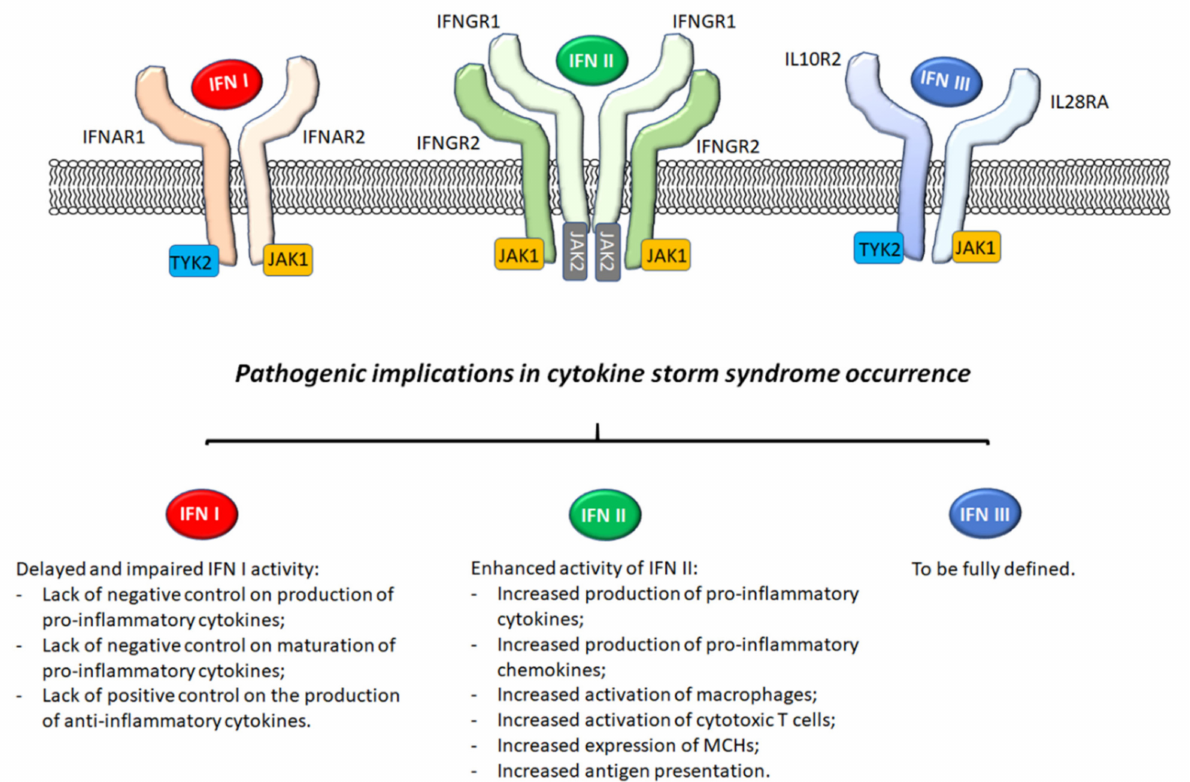
Figure 1. Pathogenic implications of IFNs in a cytokine storm syndrome occurrence. Type I IFNs bind to the IFNAR complex, consisting of two different chains, IFNAR1 and IFNAR2. Type II IFN activates the IFNGR, which is composed of two different chains, IFNGR1 and IFNGR2, and type III IFNs signal through a receptor complex made up of IL28RA and IL10R2. The impairment of the functions of type I IFNs or its delayed response may be implicated in the development of a cytokine storm syndrome lacking the negative control of production and maturation of pro-inflammatory cytokines as well as lacking the positive control on the production of anti-inflammatory cytokines. The enhanced activity of IFN II results in occurrences of cytokine storm syndrome via increased production of pro-inflammatory cytokines and chemokines and the increased activation of macrophages and cytotoxic T cells. The role of IFN III in this context has yet to be fully defined. Abbreviations: IFN: Interferon; IFNAR: interferon-alpha/beta receptor; IFNGR: interferon-gamma receptor; IL28RA: interleukin 28 receptor, alpha subunit; IL10R2: interleukin 10 receptor 2; TYK2: tyrosine kinase 2; JAK 1: Janus kinase 1; JAK 2: Janus kinase